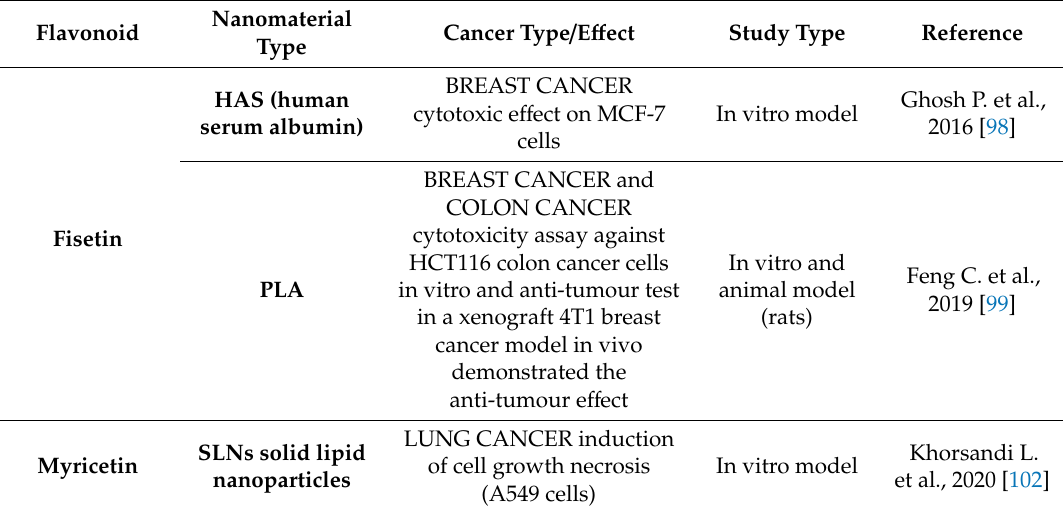
Table 9. Anticancer e ff ect of fisetin and myricetin nanoparticles in vitro and in vivo